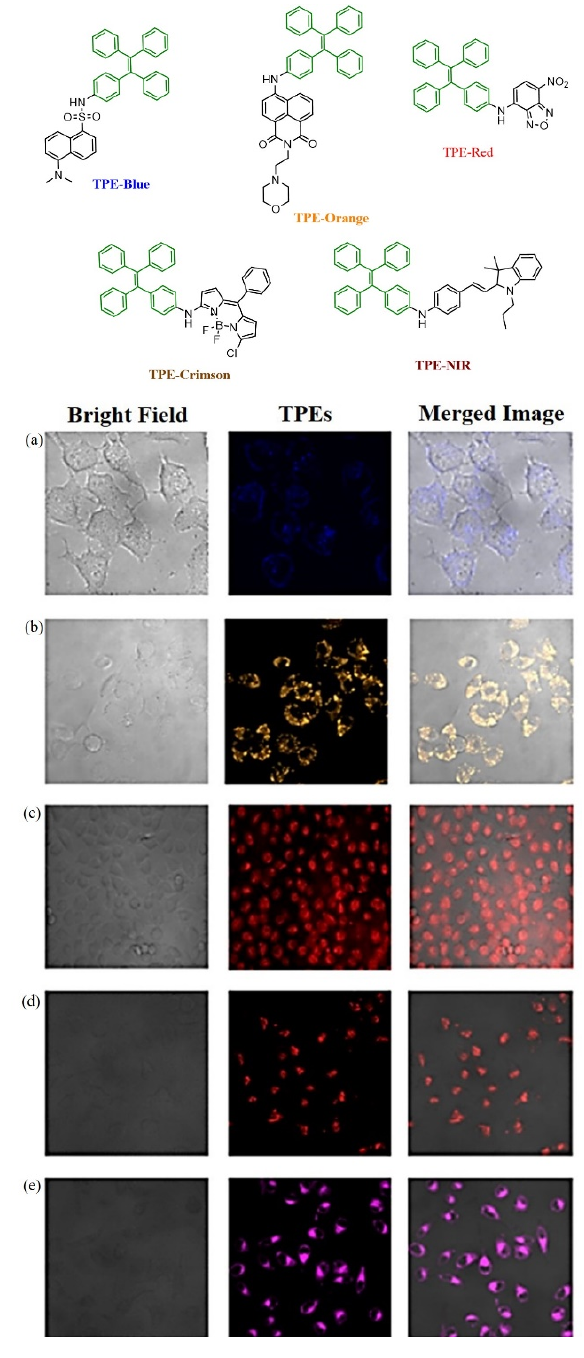
Figure 19. Structures of the fluorescent molecules TPE-NIR, TPE-Blue, TPE-Crimson, TPE-Orange, and TPE-Red are used for biological cell imaging. Confocal images of Hela cells in different emission channels with TPE-Blue ( a ), TPE-Orange ( b ), TPE-Red ( c ), TPE-Crimson ( d ), and TPE-NIR ( e ) (the near-infrared fluorescence was modified graphically to purple for visual clarity). Reprinted from reference [98] with the permission.